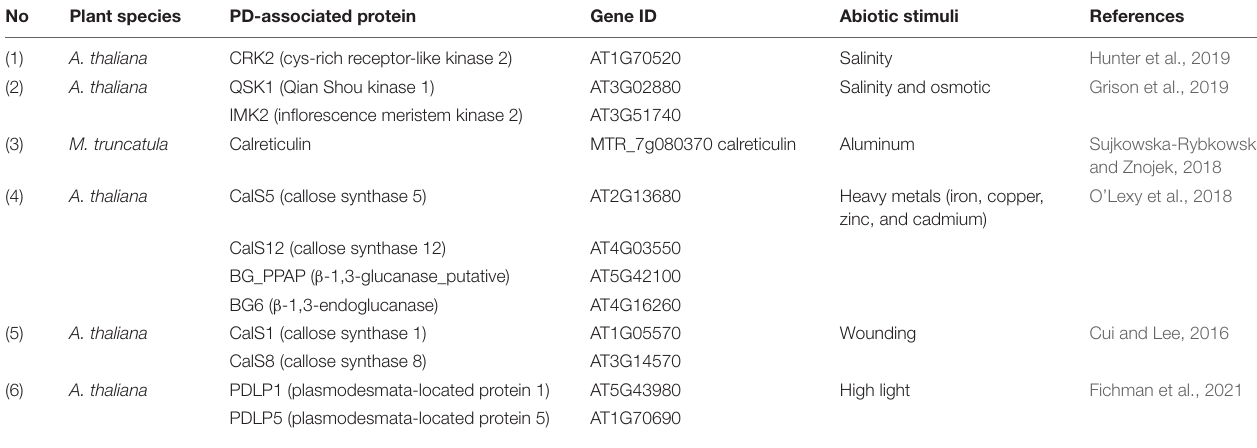
TABLE 1 | PD-associated proteins and their involvements in response to abiotic